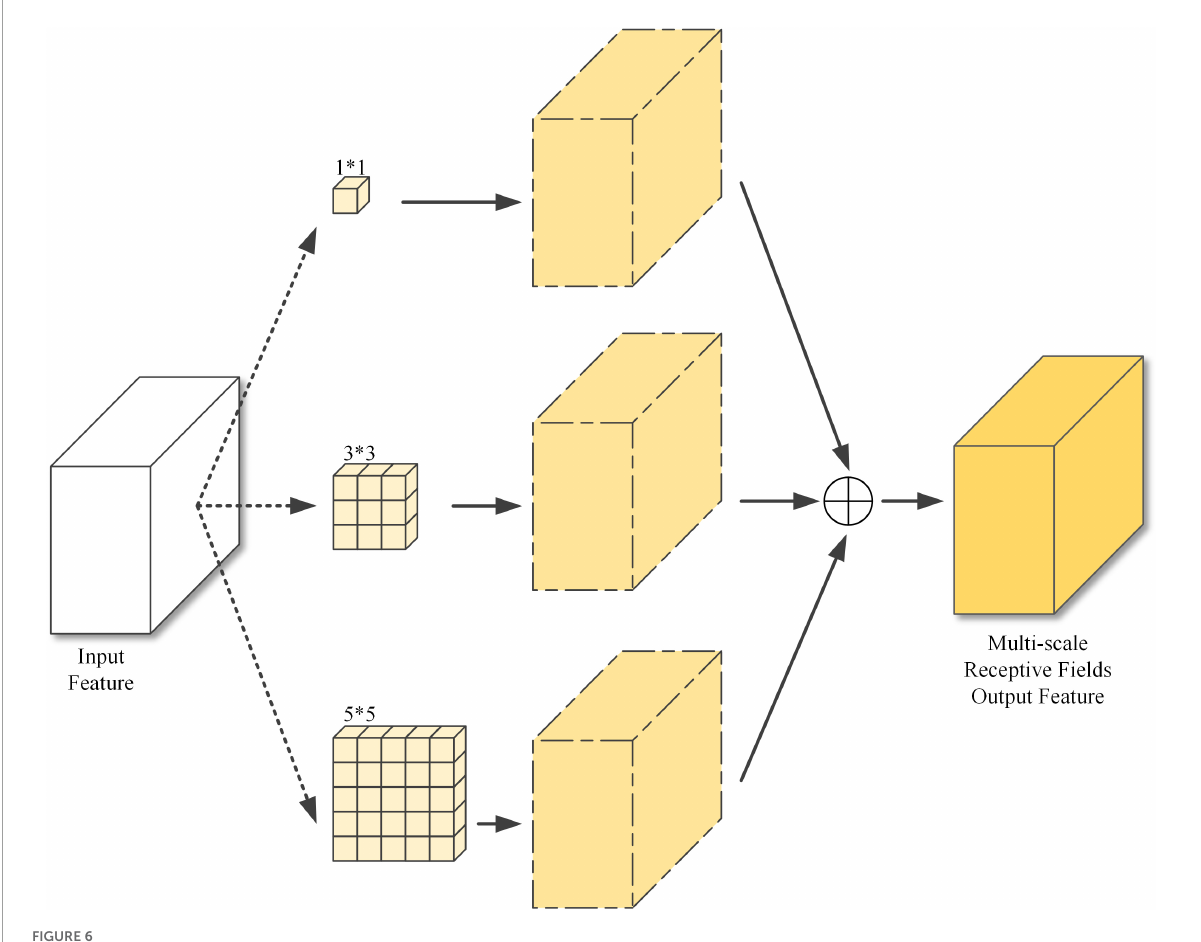
FIGURE6 Sub-module 1: Multi-scale receptive field